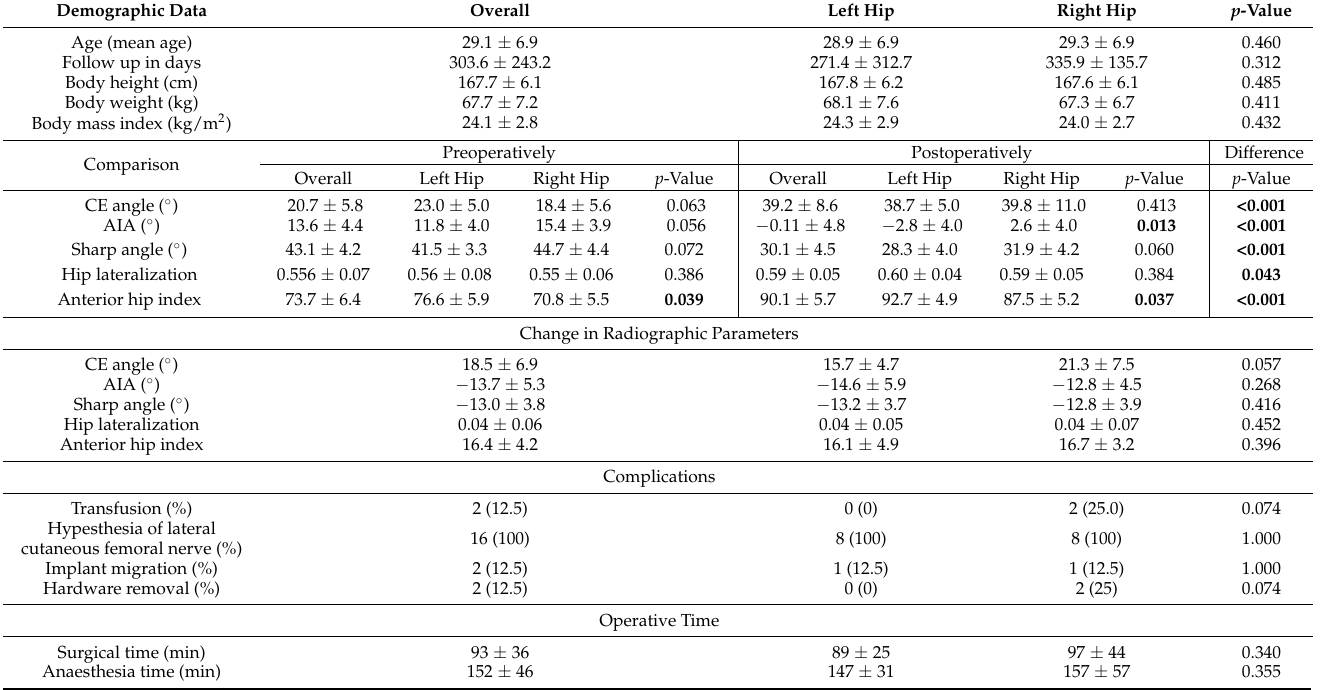
Table 6. Findings in patients who underwent bilateral PAO. (Bold values denote statistical